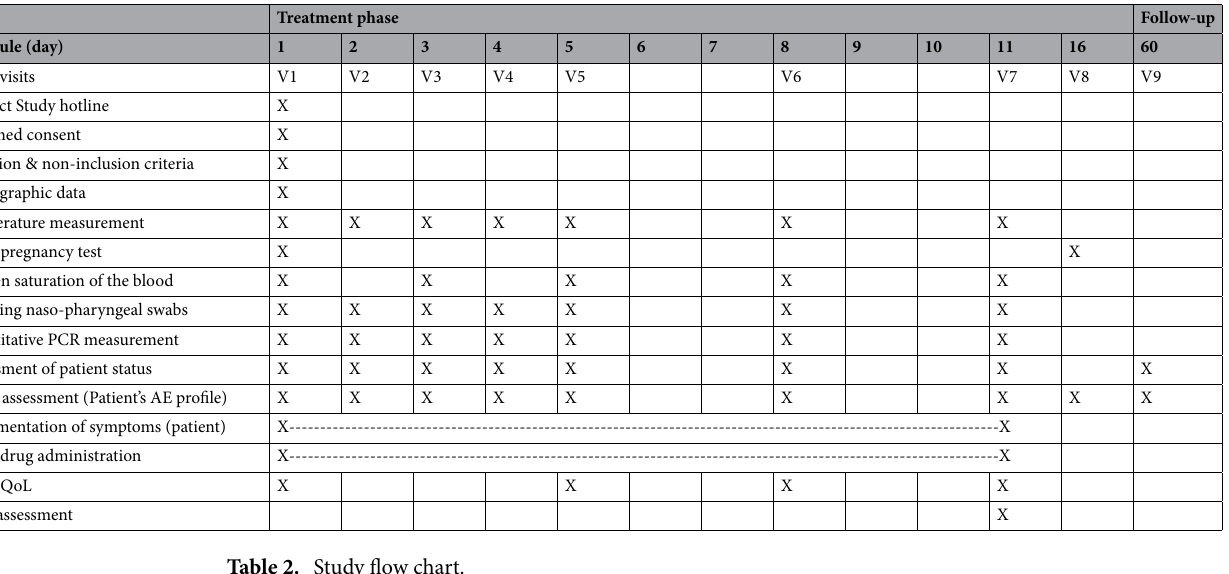
of-concept study, in which azelastine nasal spray was used in 2 doses: the commercially available concentra- tion of 0.1% and a fivefold lower concentration of 0.02%. After having given informed consent, patients tested positively for SARS-CoV-2 were examined to assess eligibility according to inclusion/non-inclusion criteria and subsequently randomized to one of the three study groups. The first administration of the nasal spray was car- ried out in the presence of the investigator; products were subsequently self-administered for 11 days (treatment phase). During the treatment phase, 7 visits (V1–V7) took place on days 1, 2, 3, 4, 5, 8 and 11. Samples of day 1 represent pre-treatment baseline samples. During visits, nasopharyngeal swabs were taken for quantitative PCR measurements, and investigators assessed the patient status in accordance with the WHO clinical progression scale 11 . Short intervals of swab collection time points, particularly during early days of infection, and high num-